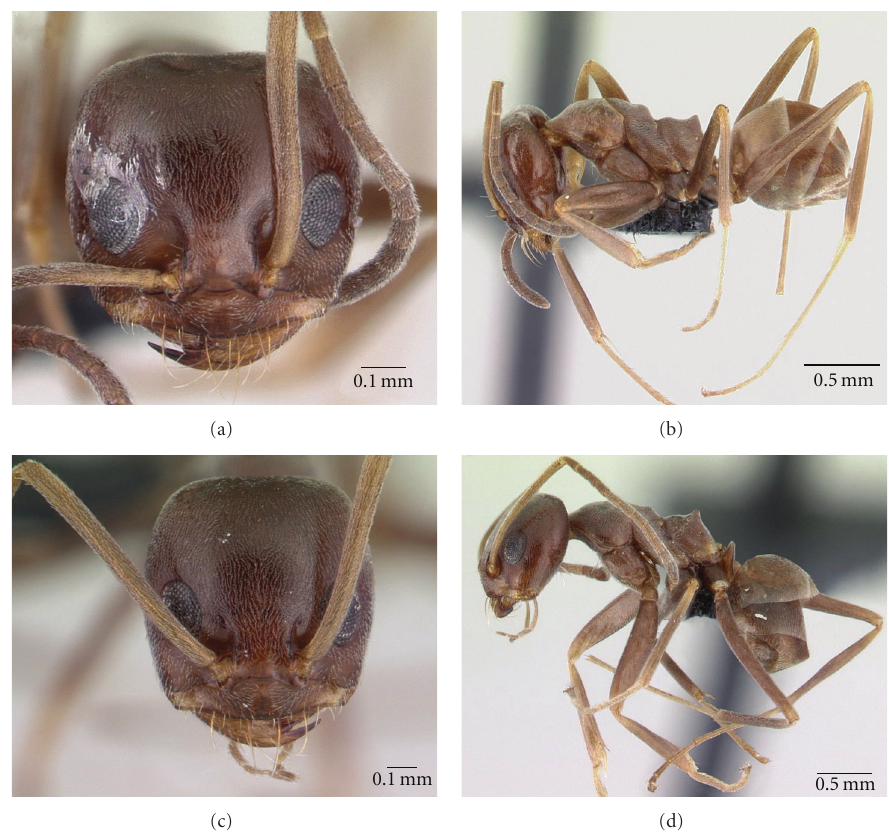
Figure 7: Dorymyrmex brunneus workers. (a) and (c) Head in full-face view; (b) and (d) body in lateral view. (a)-(b) CASENT0192705; (c)-(d) CASENT0192698. Pictures and labels of localities of each photographed specimen are available at http://www.antweb.org/.